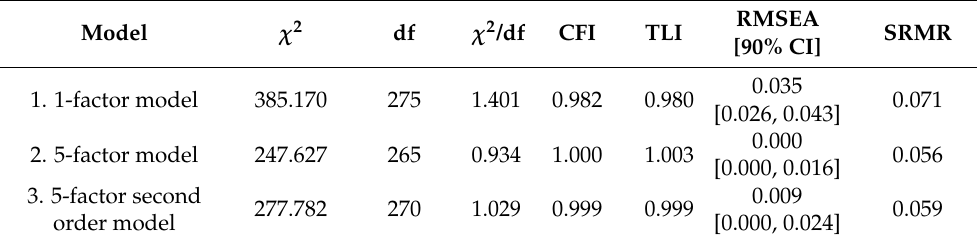
Table 2. Goodness-of-fit indices for Executive Skills Questionnaire-Revised.